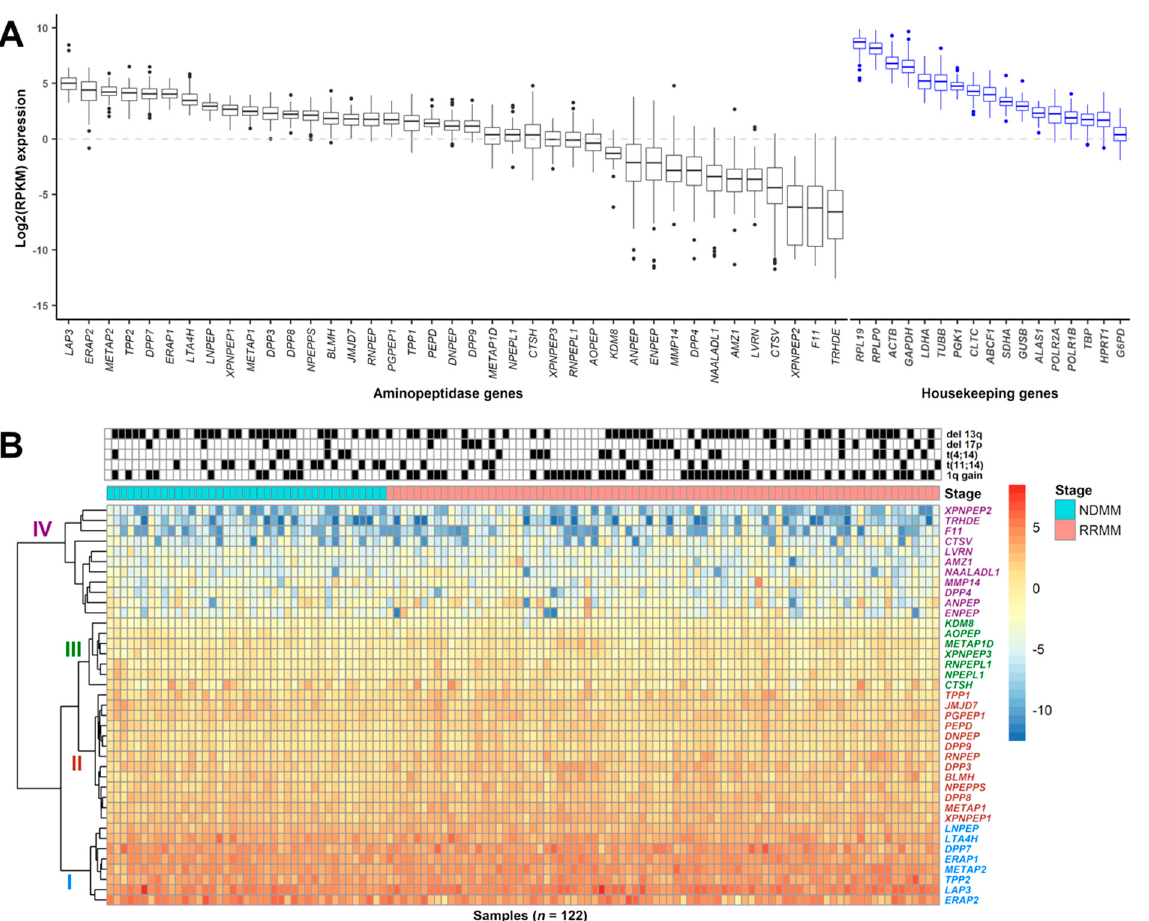
Figure 1. Expression of aminopeptidase gene family in MM patient CD138+ cells. ( A ) Boxplot showing the log2(RPKM) expression of 39 aminopeptidase and 17 housekeeping genes from 122 MM samples (NDMM ( n = 41), RRMM ( n = 81)) taken from 99 different patients. Genes are ranked based on median expression values. ( B ) Heatmap showing the hierarchical clustering of aminopeptidase gene expression, with group I (blue) containing genes with the highest and group IV (magenta) containing genes with the lowest level of expression. Groups II (red) and III (green) contain genes with an intermediate level of expression. Sample cytogenetics (del 13q, del 17p, t(4;14), t(11;14), 1q gain) are indicated above the heatmap. Disease stage indicates whether the sample was from NDMM (shown as cyan; samples on the left) or RRMM (pink; samples on the right). RPKM: reads per kilobase of transcript per million mapped reads; MM: multiple myeloma; NDMM: newly diagnosed multiple myeloma; RRMM: relapsed/refractory multiple myeloma.